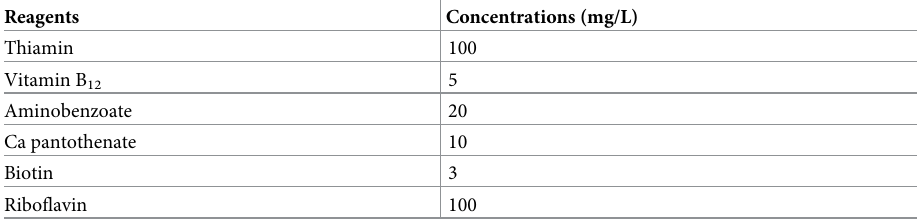
Table 3. The vitamin mixture compositions in defined